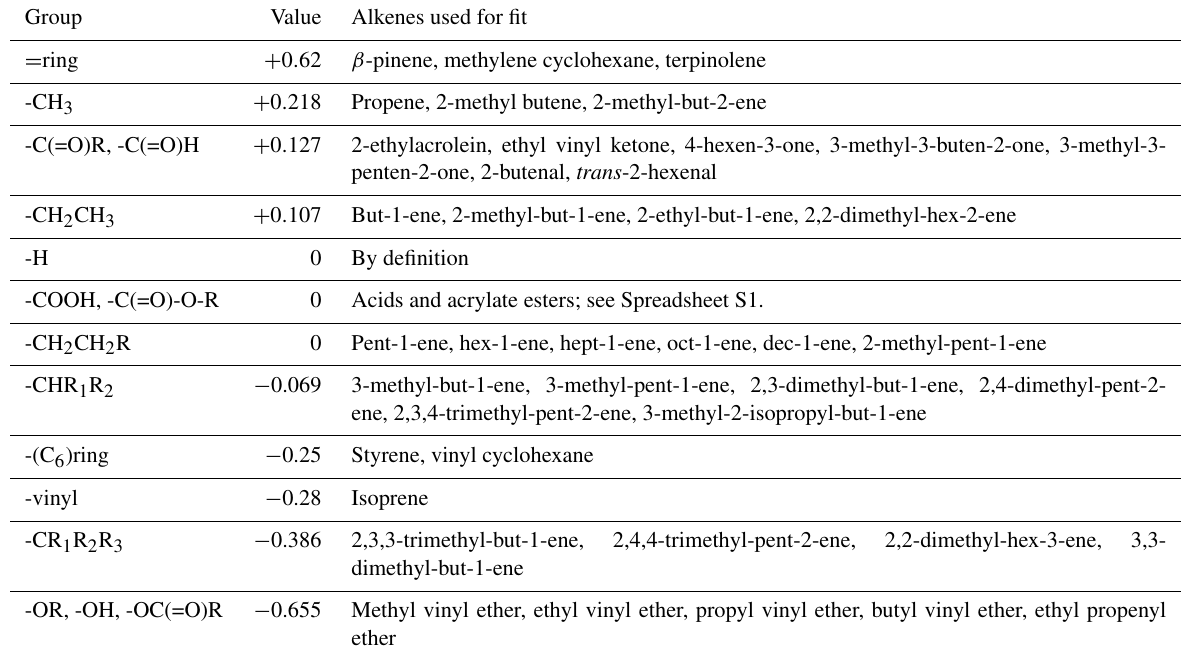
− 0.655 Methyl vinyl ether, ethyl vinyl ether, propyl vinyl ether, butyl vinyl ether, ethyl propenyl